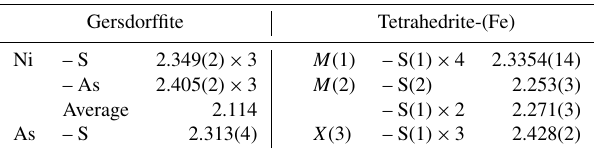
Table 5. Selected bond distances (in Å) for gersdorffite and tetrahedrite-(Fe).